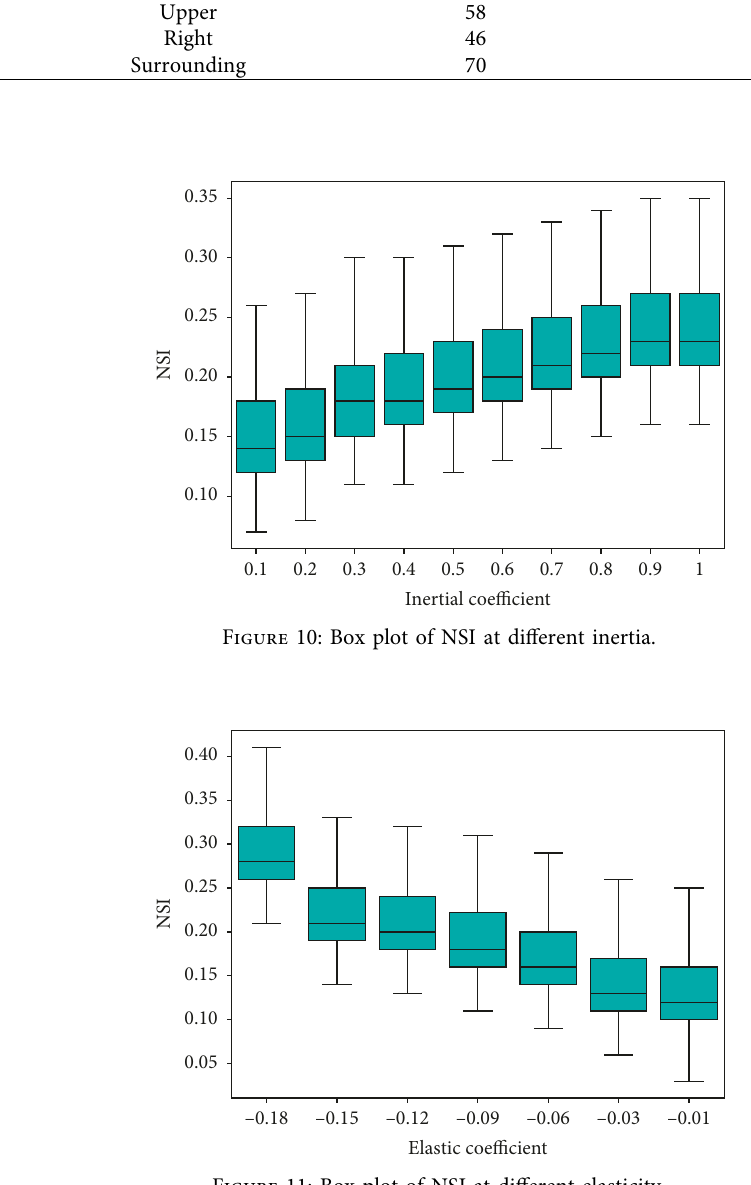
Figure 11: Box plot of NSI at different